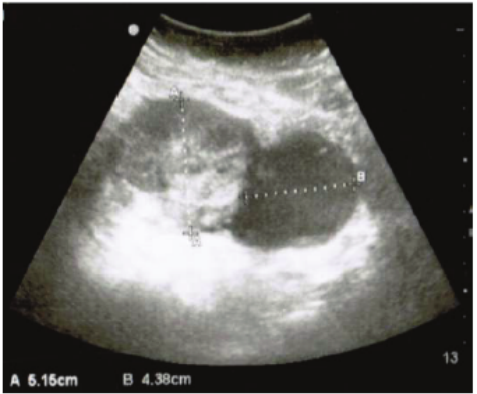
Figure 1: Ultrasonography at 30 weeks showing a complex adnexal